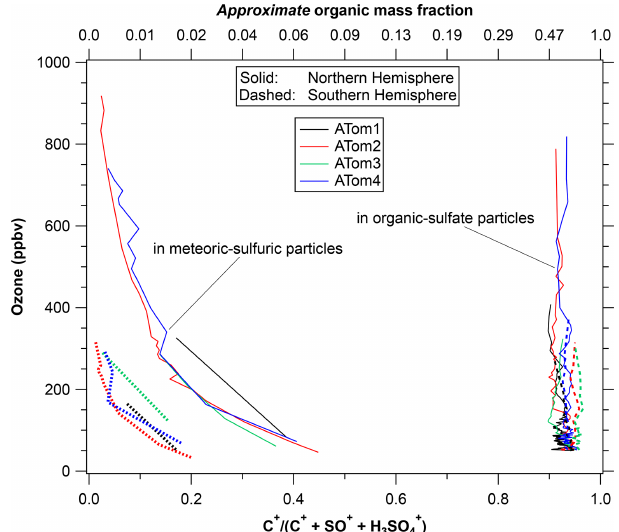
Figure 6. The organic content of two types of stratospheric particles using ozone as a surrogate for altitude. Shown are the relative areas of the C + peak in the mass spectra relative to two peaks indica- tive of sulfate. The top axis is an approximate mass fraction. The organic–sulfate particles are about 40% to 70% organic by mass, consistent with a tropospheric source. The sulfuric acid particles have near-zero organic content well into the stratosphere, increas- ing up to a few percent by mass near the tropopause. There was a strong difference in the organic content of the sulfuric acid particles between the hemispheres. Each point is the average of about 200 mass